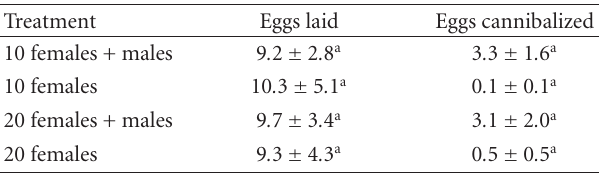
Figure 3: Three-chambered arena designed to measure beetle movement and oviposition in response to odors from methyl sal- icylate (MeSA). Beetles are visible in the central chamber.